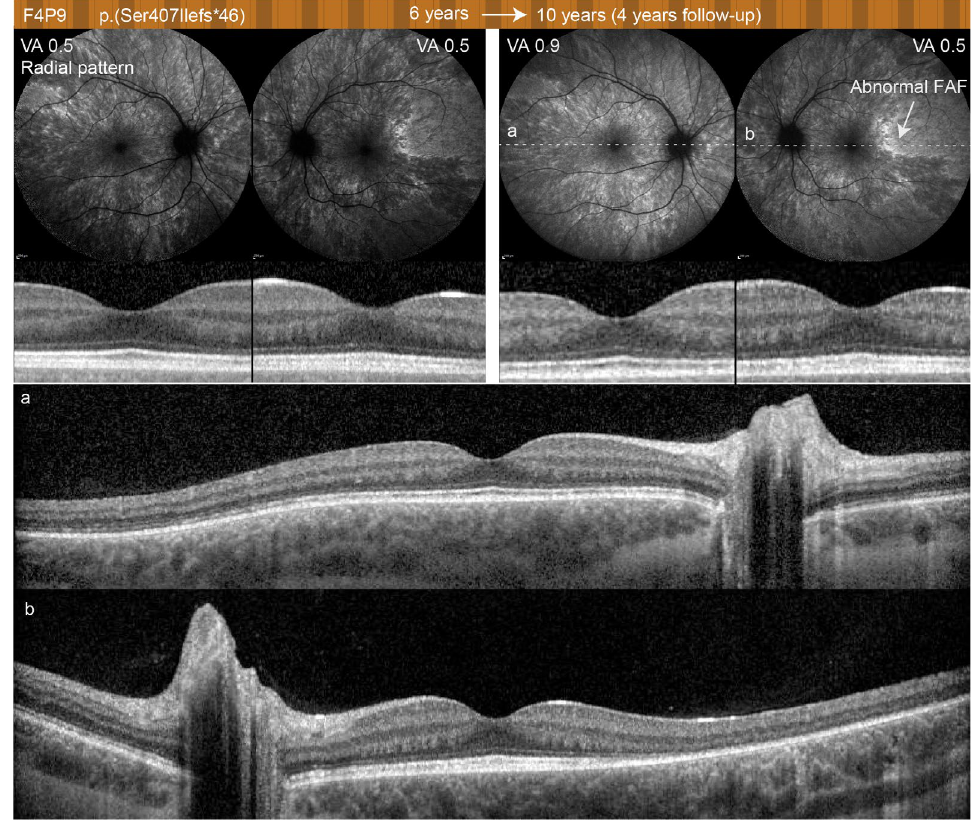
Figure 11. FAF and central OCT of females from family 4 with a follow-up after 4 years. Dashed lines show the location of the OCT scan through the whole macula at the last visit shown below ( a , b ). Note that the relatively brighter signal on the FAF image in the temporal part of the macula corresponded to photoreceptor loss on the OCT in that region.